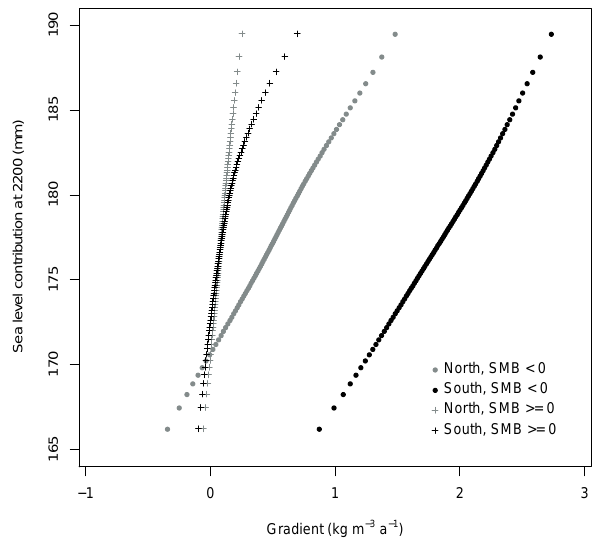
Fig. 5. GISM-SIA projections for sea level contribution in 2200 as a function of elevation feedback gradient